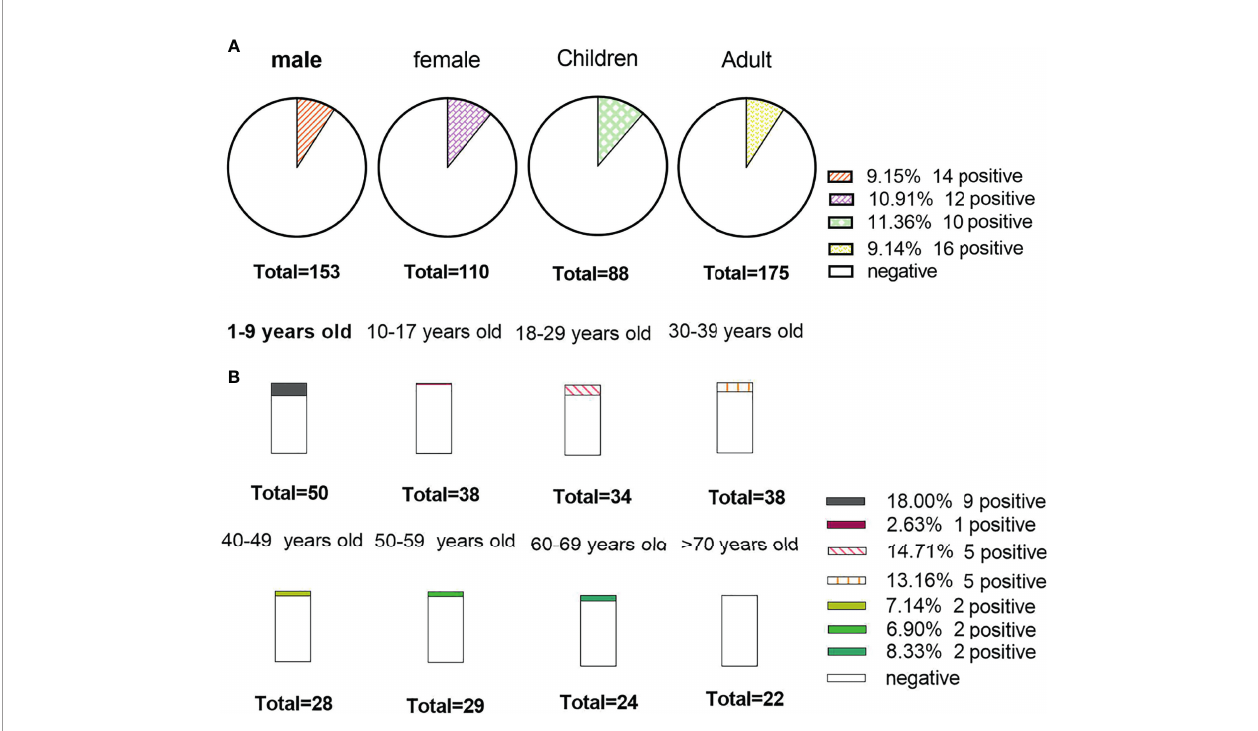
FIGURE 4 | The positive rate of the study data strati fi ed by sex and age. (A) Detection results of antibody among sexes, children and adults; (B) The positive rate among different age